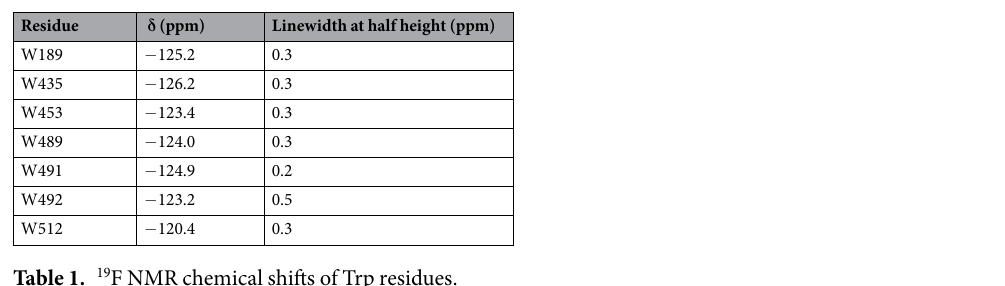
Table 1. 19 F NMR chemical shifts of Trp